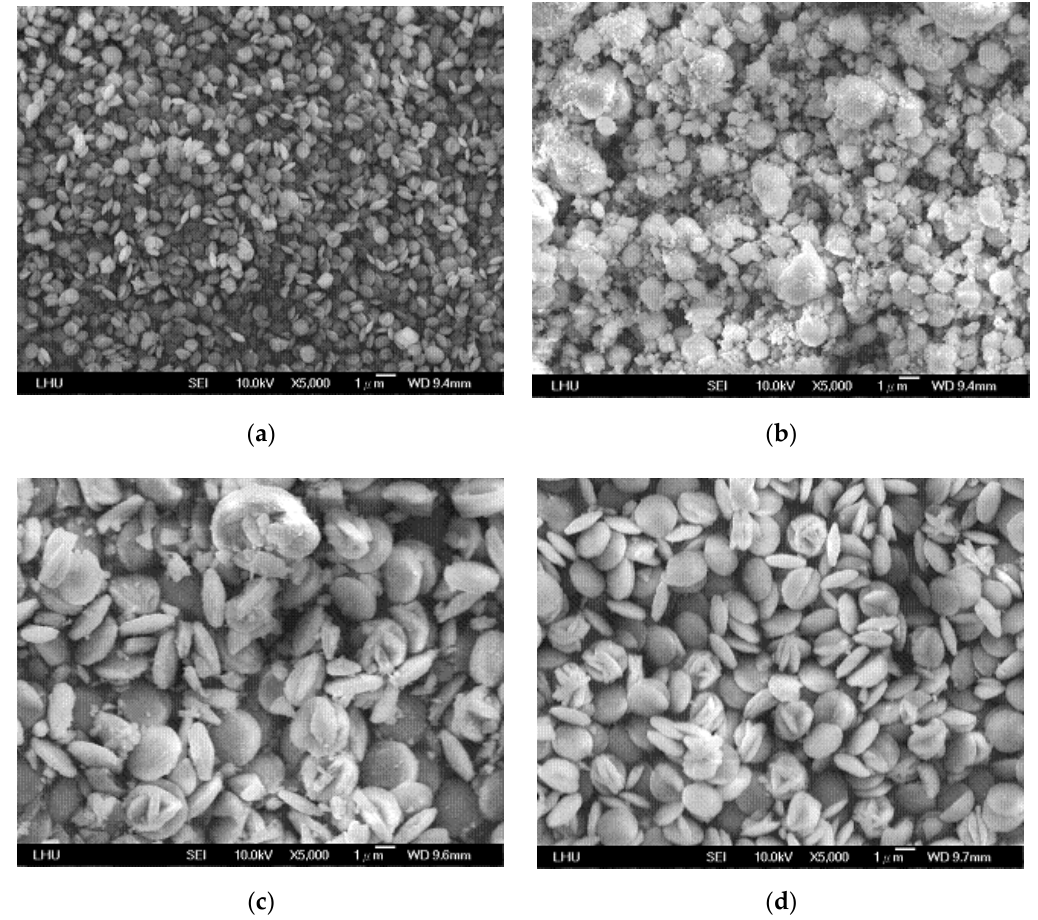
Figure 4. Effects of Q g on the morphology and crystal size of vaterite. ( a )Q g = 2 L/min (d p = 1.60 μ m) (No. 1);( b )Q g = 4 L/min (d p = 1.33 μ m) (No.4); ( c ) Q g = 6 L/min (d p = 1.14 μ m) (No. 7);( d )Q g = 8 L/min (d p = 1.01 μ m) (No. 10).